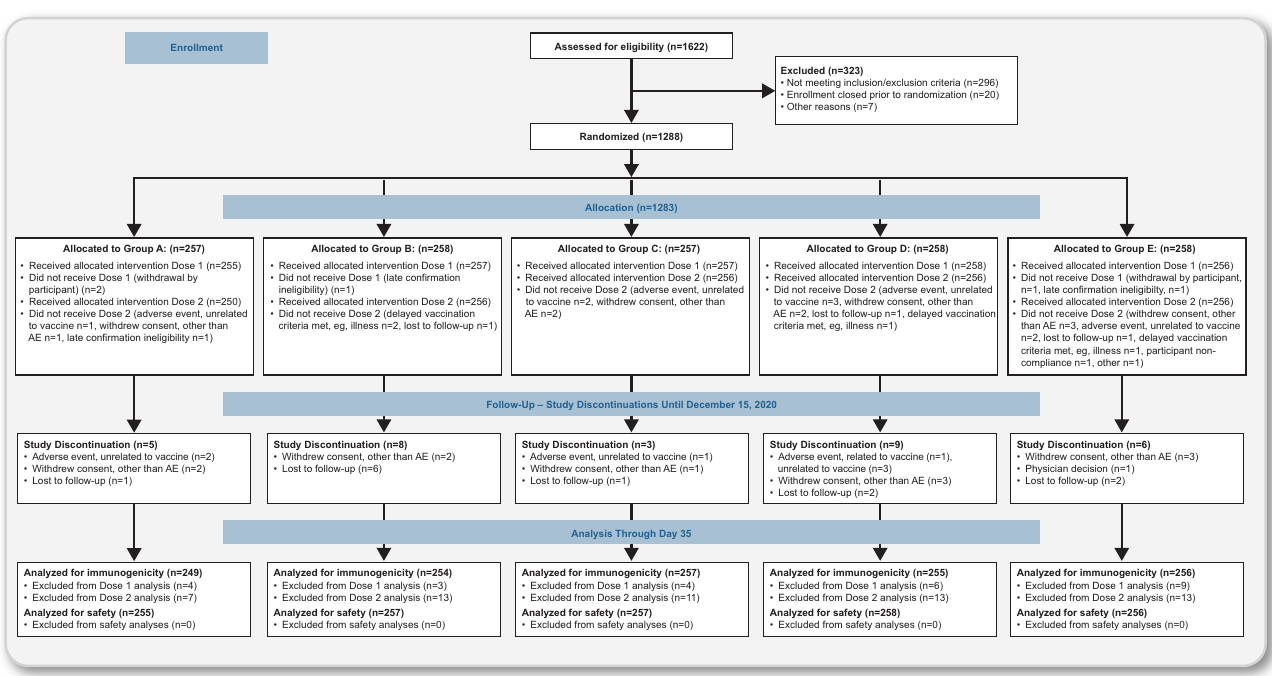
Fig 1. CONSORT flow diagram. Notes: Study AU : PerPLOSstyle ; subjectsshouldnotbeusedforhumans : PleasechangesubjecttoparticipantinFig 1 ; specificallyinwithdrawalbysubject ; andprovideanewFig 1 file : treatments Dose 1 / Dose 2: Group A: placebo / placebo; Group B: 5- μ g SARS-CoV-2 rS + M1 / 5- μ g SARS-CoV-2 rS + M1; Group C: 5- μ g SARS-CoV-2 rS + M1 / placebo; Group D: 25- μ g SARS-CoV-2 rS + M1 / 25- μ g SARS-CoV-2 rS + M1; Group E: 25- μ g SARS-CoV-2 rS + M1 / placebo (M1 = 50- μ g Matrix M1 adjuvant). Details of the analysis sets are included in the Supporting methods section.